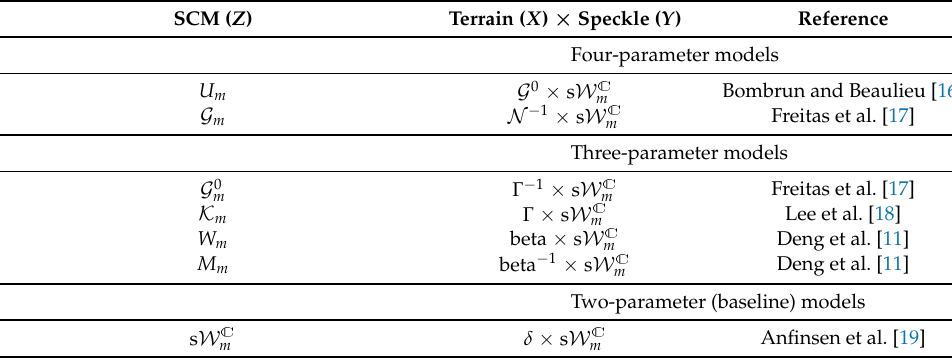
Figure 1. Diagram of limit relationships among PolSAR distributions. Here, the parameters α and β represent shape, Σ denotes a kind of location, and L is the equivalent number of looks (ENL). Table 1. Summary of SCM